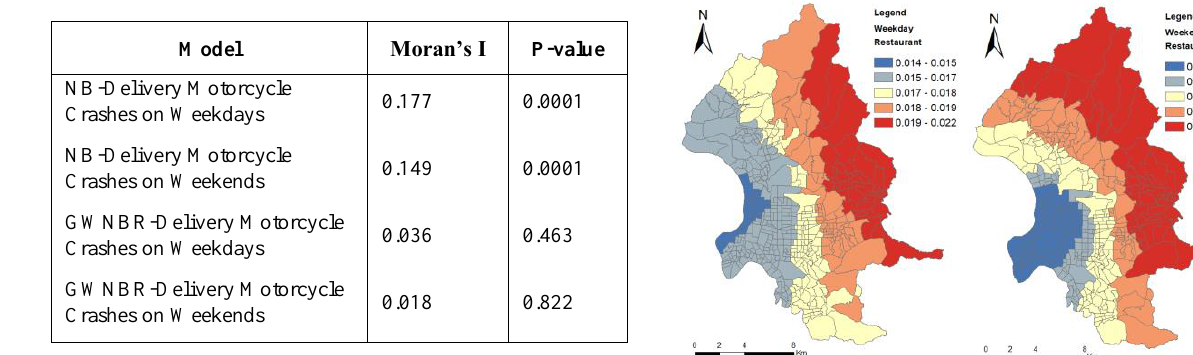
Table 4 . Global Morans’ I from each model.